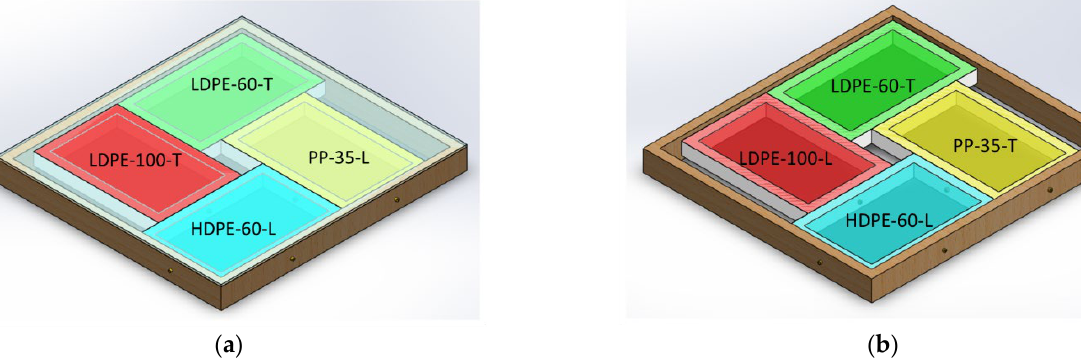
Figure 5. Experimental set up scheme. ( a ) Transparent films distribution with glass. ( b ) Transparent film distribution without glass.